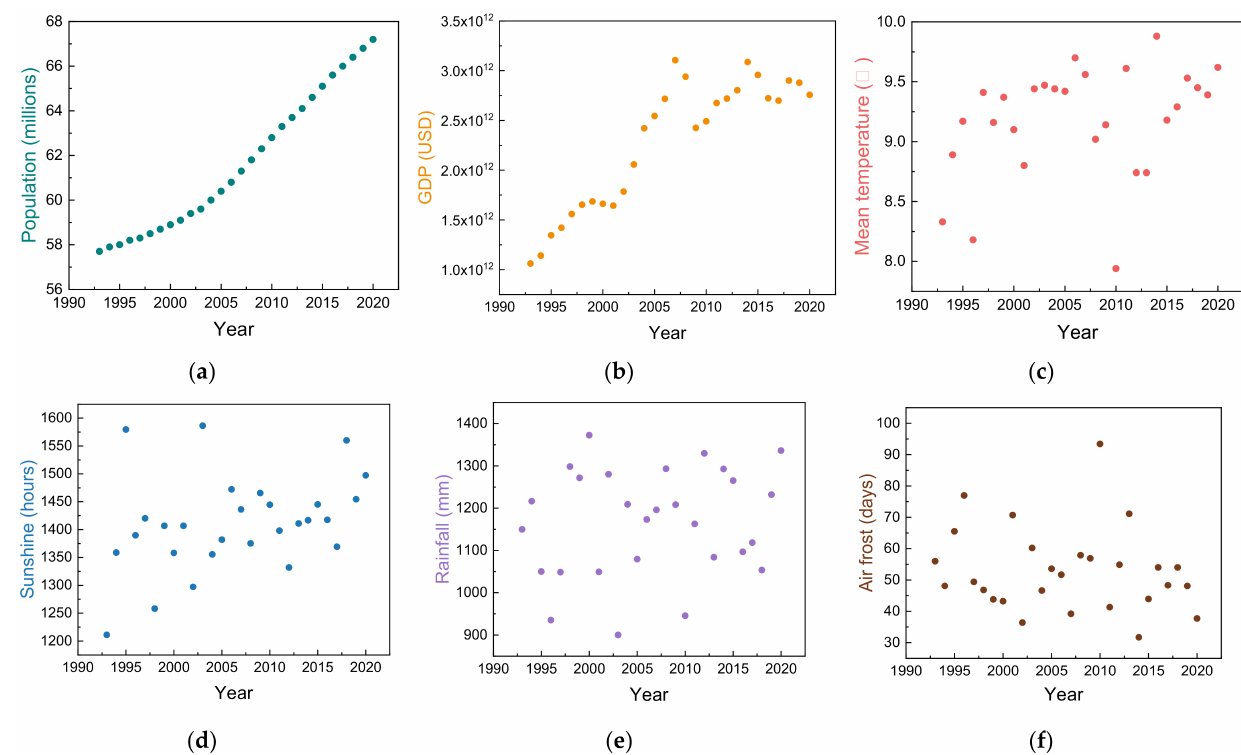
Figure 2. Variations of original data for input variables in 1993–2020. (( a ) population; ( b ) GDP;